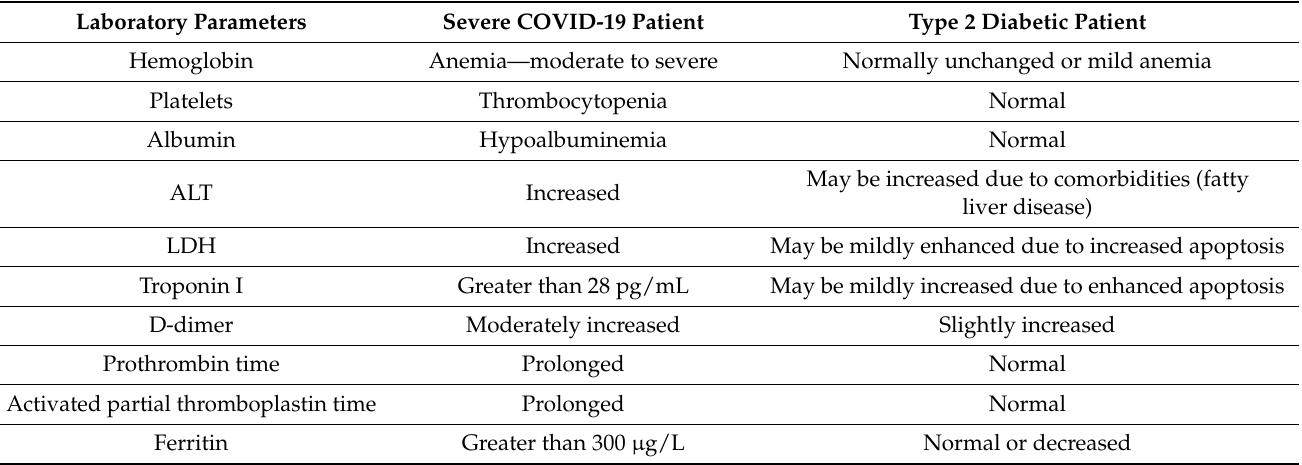
Table 1. Laboratory findings of the most assessed parameters in severe COVID-19 and type 2 diabetic patients [59].